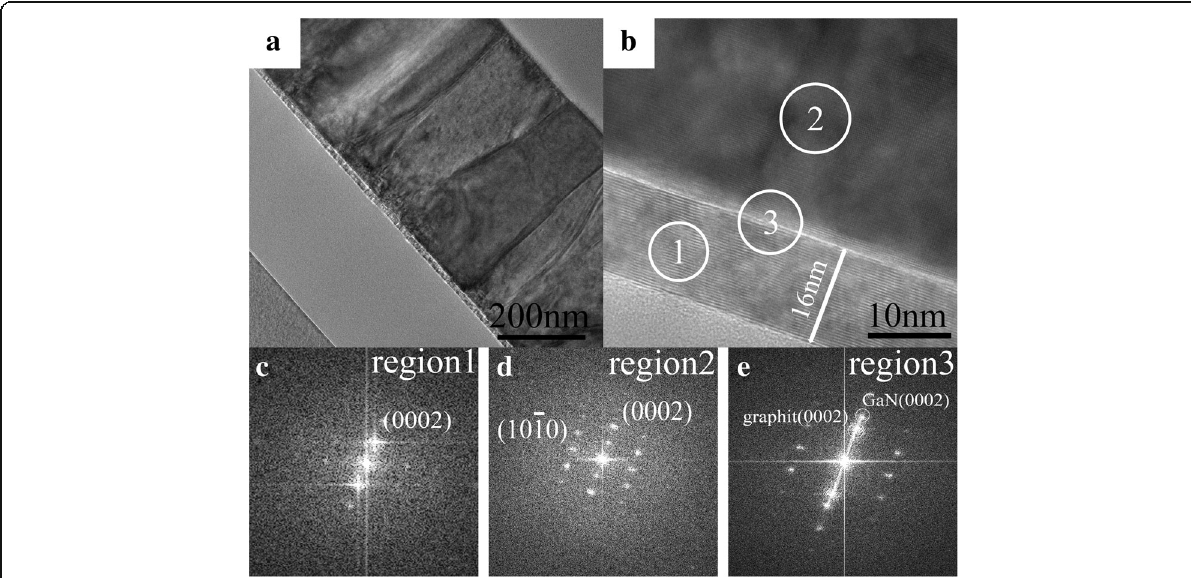
Fig. 6 a , b TEM and HR-TEM cross-section micrographs (along h-GaN [010]) showing the GaN and graphite interface. c – e Fourier transform diffraction patterns for graphite, GaN films, and their interface,